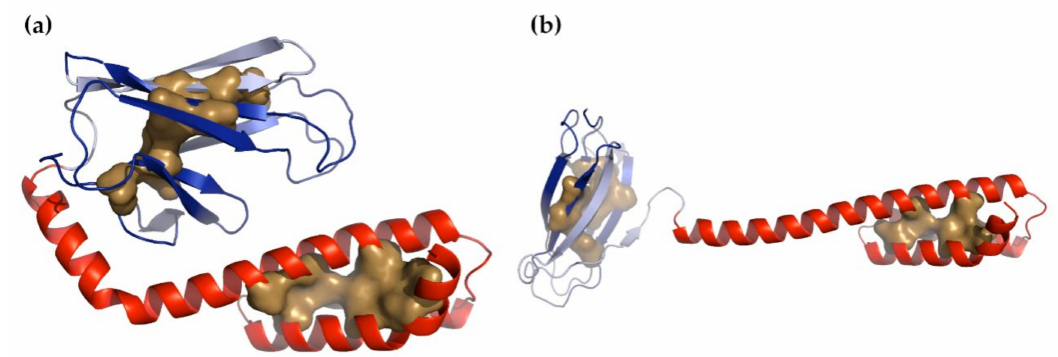
Figure 5. The compact and extended forms of the Hsp70 substrate binding domain. The β -domain is blue, the α -domain is red, and the two C-terminal β -strands of the β -domain ( β 7 and β 8) are shown in light blue. ( a ) Compact, substrate-bound form (from PDB structure 2KHO [51]) and ( b ) extended form (from PDB structure 4B9Q